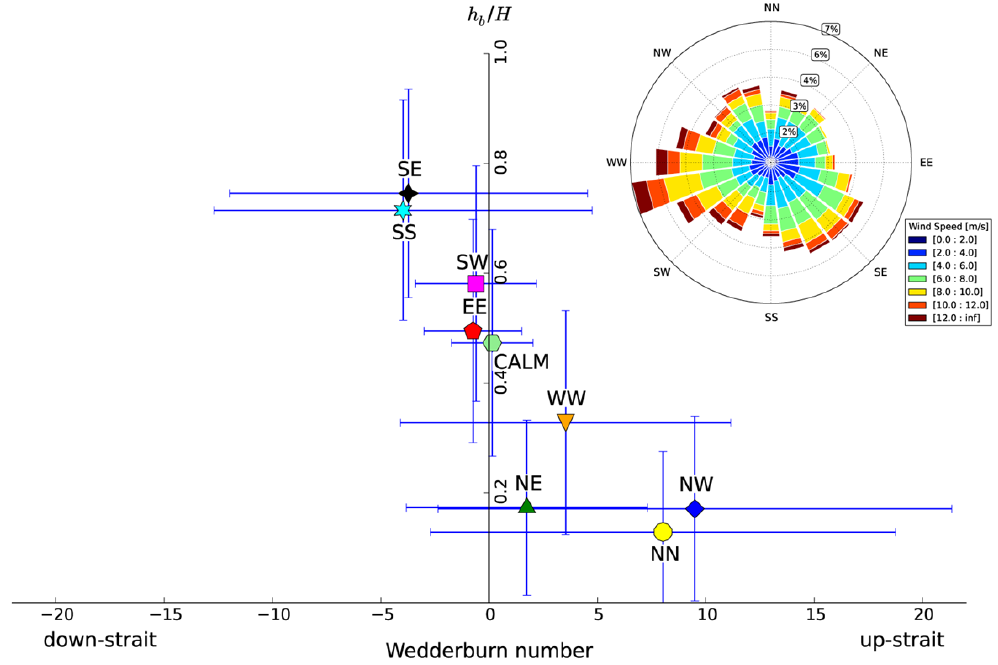
Fig. 10. Flow-regime diagram to classify the effect of the wind on stratification in the Klaip˙eda Strait. The y-axis is the ratio of buoyancy layer depth ( h b ) to total water depth ( H ); the x-axis is the Wedderburn number ( W ). Positive is up-strait and the blue error-bars indicate the standard deviation of W . Symbols identify the mean values of each sub-sample based on the wind direction (from NN, NE, EE, SE, SS, SW, WW and NW) and the no-wind situation (CALM; sub-sample of cases with wind intensity lower than 3ms − 1 ) . In the upper right panel the wind rose obtained from HIRLAM model results for the Klaip˙eda Strait is